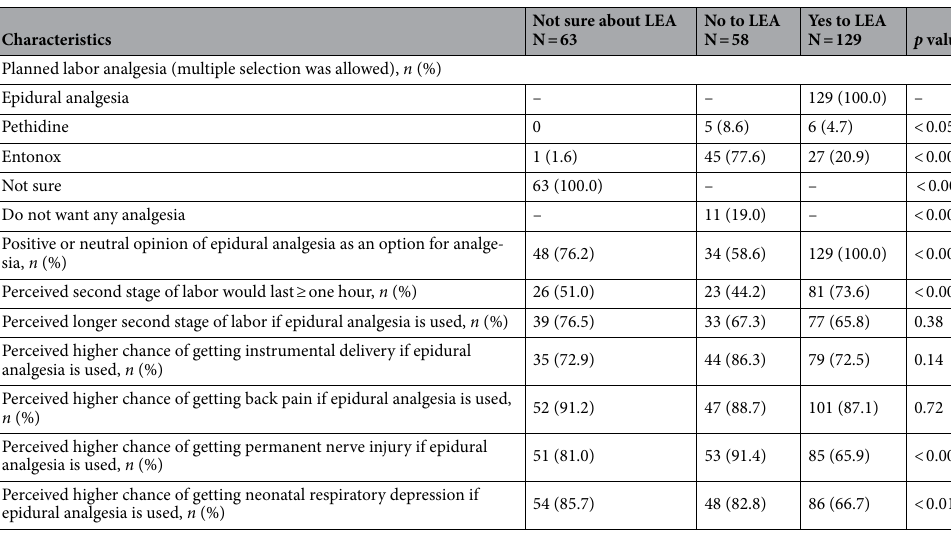
Table 2. LEA preferences and other opinions on labor and delivery. LEA labor epidural analgesia.